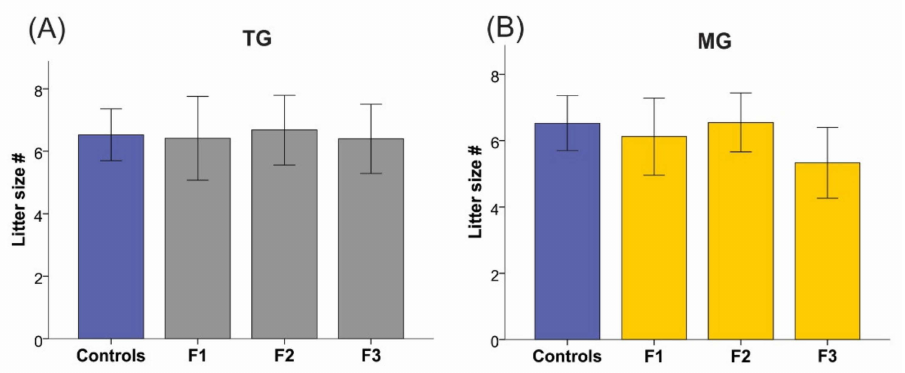
Figure 4. Litter sizes remained unchanged. Litter sizes of dams exposed to SIS did not change in the TG ( A ) and MG ( B ) groups. Controls n = 18; F1 n = 6–8, F2 n = 11; F3 n = 9–10. Mean ± SEM. 2.5. Neonatal Growth was Affected in Animals Exposed to SIS, While Plasma Levels of Corticosterone (CORT) Remained Unchanged in the Parental Generation Plasma CORT levels are measured to confirm the presence of stress. Unexpect- edly, plasma collected on GD18 displayed basal CORT levels in F0 stressed animals (543 ± 261 ng/mL; Figure 5A) compared to controls (582 ± 332 ng/mL). Levels of CORT were significantly increased in the F1 generation (1399 ± 722 ng/mL, p = 0.001) of the TG lineage than those of F2 animals (350 ± 179 ng/mL; Figure 5A). The MG lineage demon- strated an overall increase in CORT levels ( p = 0.037) (Figure 5B), and higher CORT levels were associated with increased blood glucose levels on GD18 in F2 TG-stressed animals (Figure 5C,D).